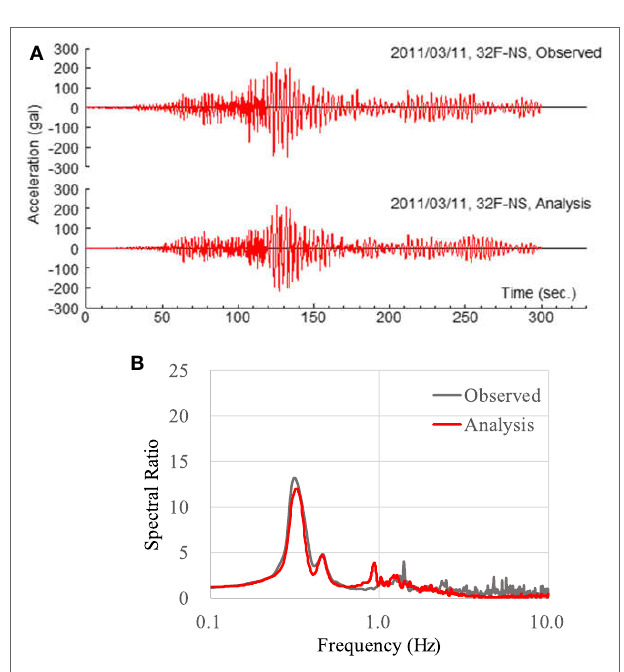
FigUre 10 | Comparison of observed and analytical response for the 3/11 main shock (N–S direction): (a) acceleration waveforms for 32F and (B) transfer function between 32F and ground level.